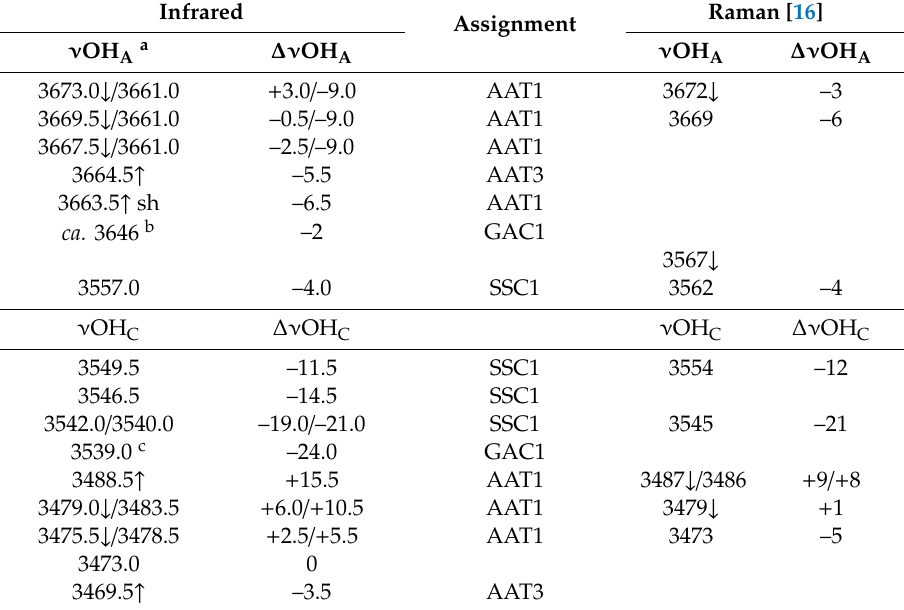
Table 1. Experimental positions of the ν OH bands and their shifts (in cm − 1 ) observed for GA ... N 2 complexes in argon matrices. Infrared